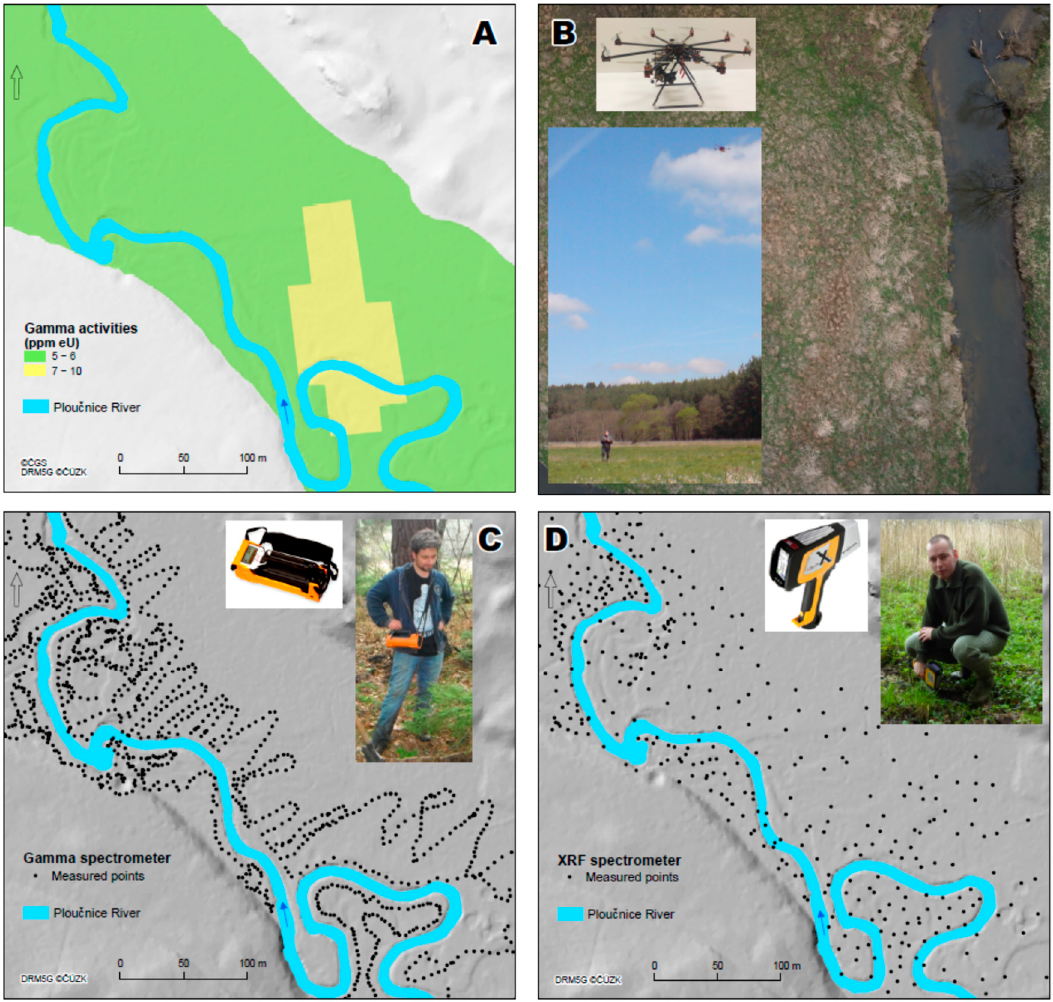
Figure 3. Mapping instruments in the MS-West of Hradˇcany study area: Low resolution gamma activity survey ( A ), drone and detail of a high-resolution image ( B ), gamma spectrometer and measuring points ( C ), and X-ray fluorescence (XRF) spectrometer and measuring points ( D ).